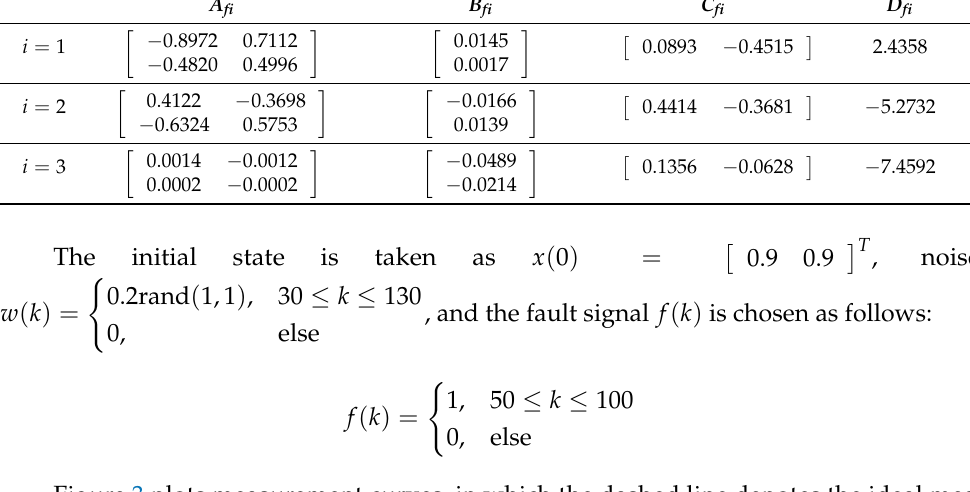
Table 1. The computed gains of the fault detection filter.